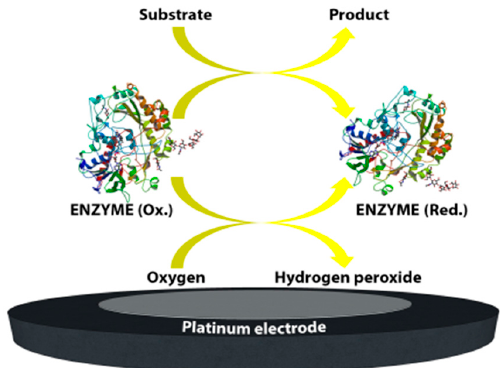
Figure 1. A schematic representation of first-generation glucose.